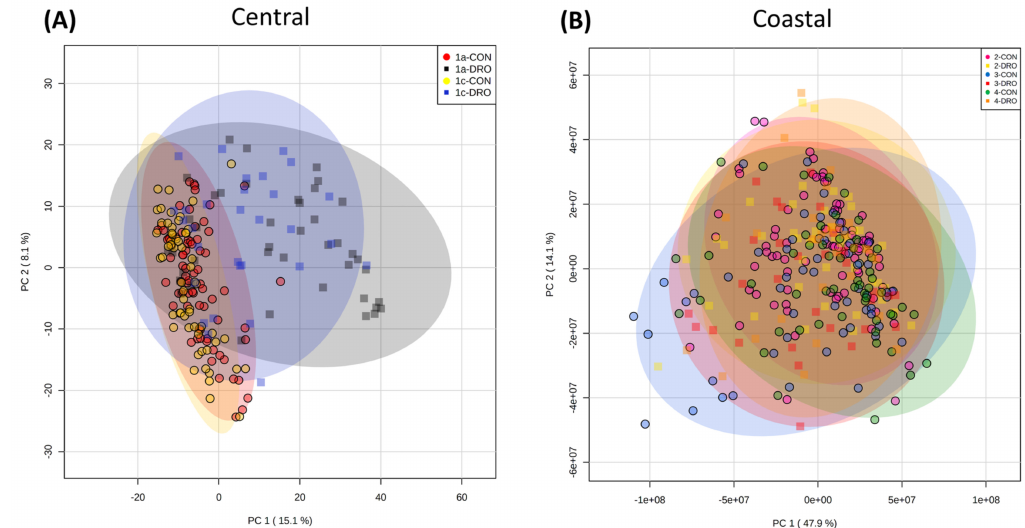
Figure 5. The metabolomes of Brachypodium central and coastal accessions under drought stress and in controls. Eight- week-old Brachypodium accessions were transferred to the National Plant Phenomics Centre, Aberystwyth, UK. The watering was regulated to soil water contents (SWC) of 15% (droughted, DRO), 40% and 75% (controls, CON). After 12 days of drought, leaves were sampled and the metabolomes were assessed using FIE-HRMS. Principal component analysis of Brachypodium accessions within the ( A ) central (Turkish climatic regions 1a, 1c) and ( B ) coastal (Turkish climatic regions 2, 3, 4) subpopulations [6].